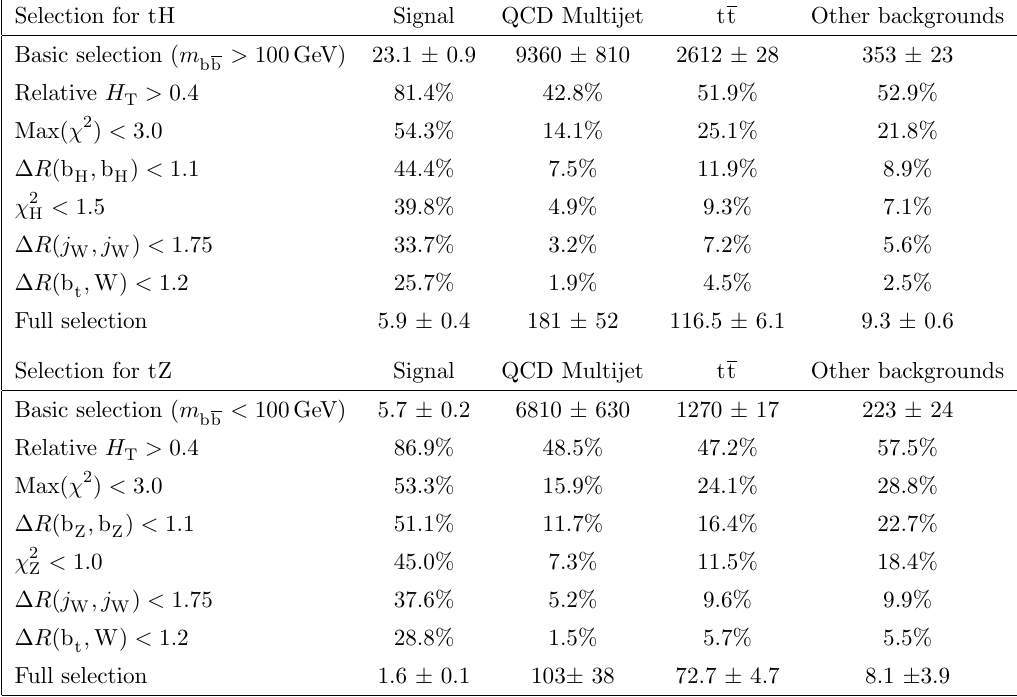
Table 1 . Cumulative e(cid:14)ciencies for the low-mass search after applying event selections for the signal and main backgrounds in the Higgs boson decay channel (upper half) and the Z boson decay channel (lower half). The (cid:12)rst and last rows of each section give the expected numbers of events normalized to the integrated luminosity of 35.9 fb (cid:0) 1 . Uncertainties are statistical only. The signal values are for a mass of 0.7 TeV, (cid:0) =m = 0 : 01, left-handed chirality, and a T quark produced in T association with a bottom quark with a product of cross section and branching fraction of 89 fb for each channel. The \Other backgrounds" column includes W+jets, Z+jets, single top quark, and ttH processes. It has been checked that the ttH process does not present a resonance in the tH channel. The number of expected ttH events is comparable to the expected T